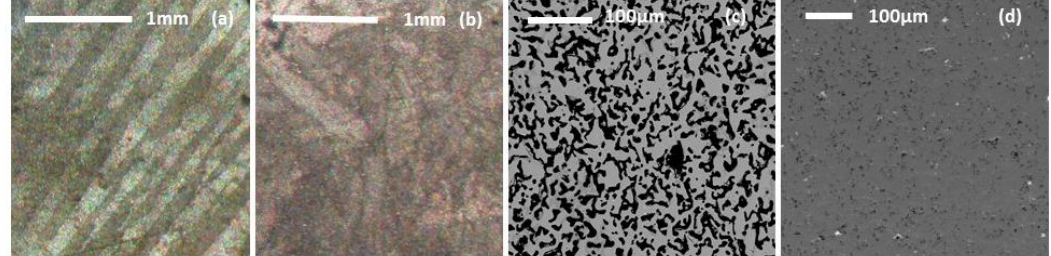
Figure 1. Structural images of miniature disks of Terfenol-D: cut from single crystals rod. ( a ) cut from cast polycrystalline ingot; ( b )-optical images, and hot-pressed from powder (0–38 µm) with conventional heating; ( c ) and SPS (Spark Plasma Sintering); ( d )-SEM images.